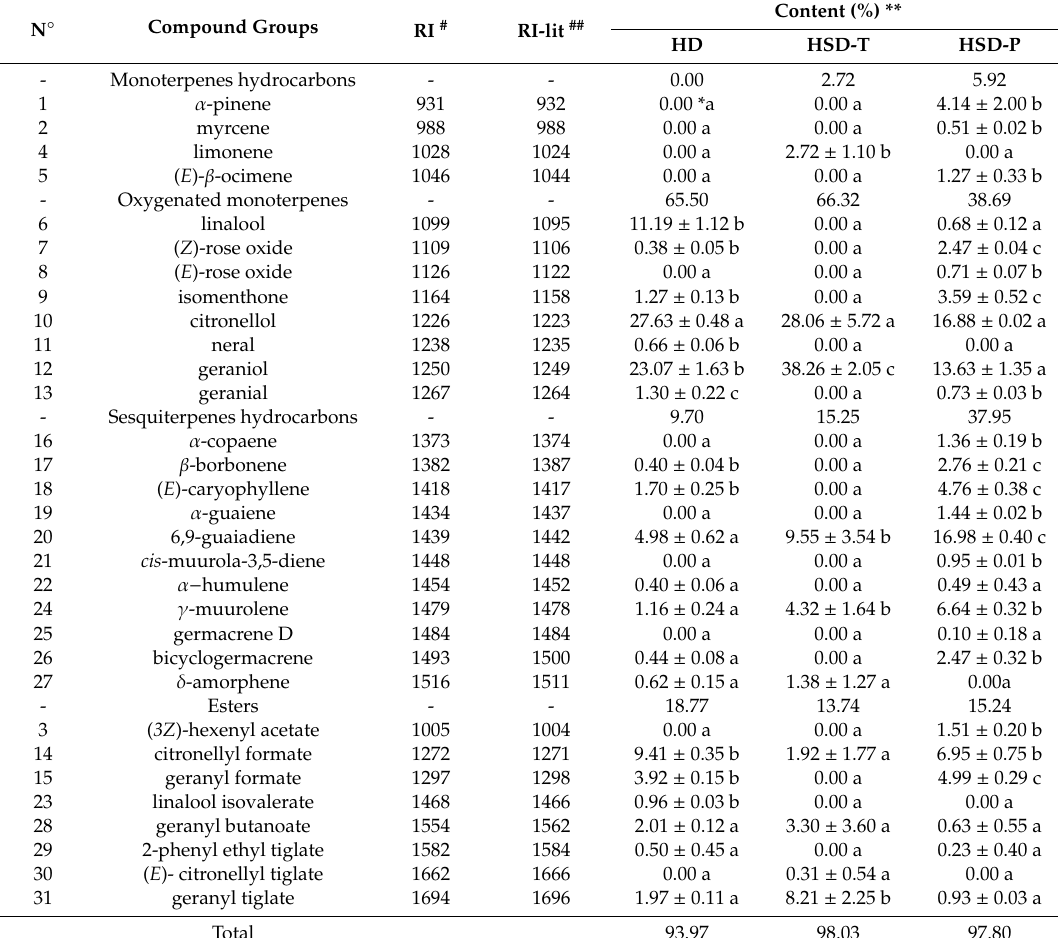
Table 1. Composition of P. graveolens obtained by hydrodistillation (HD), Porapak Q (HSD-P) and peat